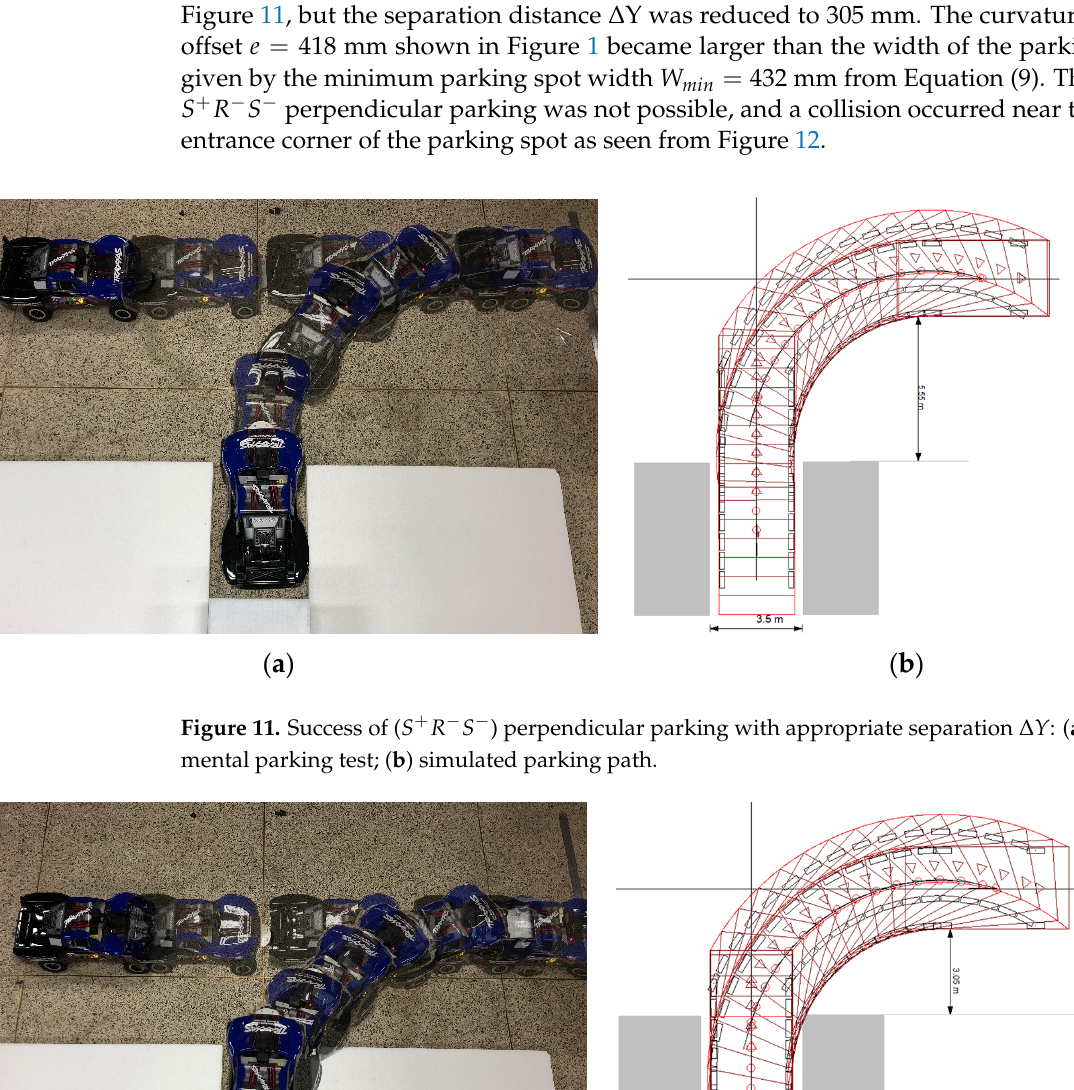
( b ) Figure 13. Five-characters ( 𝑆 (cid:2878) 𝐿 (cid:2878) 𝑆 (cid:2878) 𝑅 (cid:2879) 𝑆 (cid:2879) ) perpendicular parking in a narrow spot: ( a ) Experimental parking test; ( b ) simulated parking path.